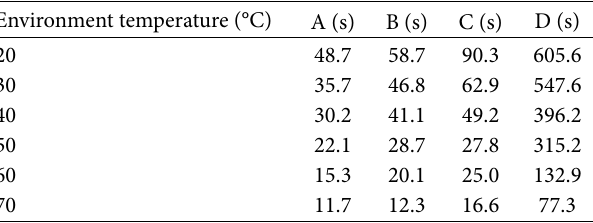
Table 6: Gelation time of the anchorage of different types of resin in different temperature